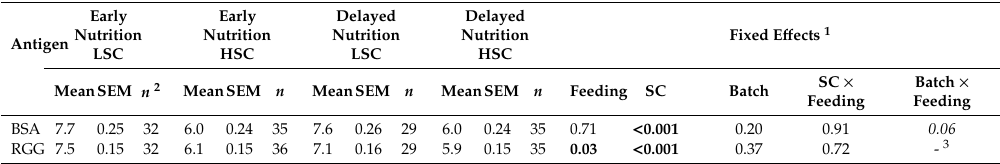
1 Model established p -values for fixed e ff ect of sanitary condition, feeding strategy, batch, and their two-way interactions. 2 Number of replicate broilers, housed with 4–5 broilers per pen. 3 Batch * Feeding e ff ect was left out of the model as p >